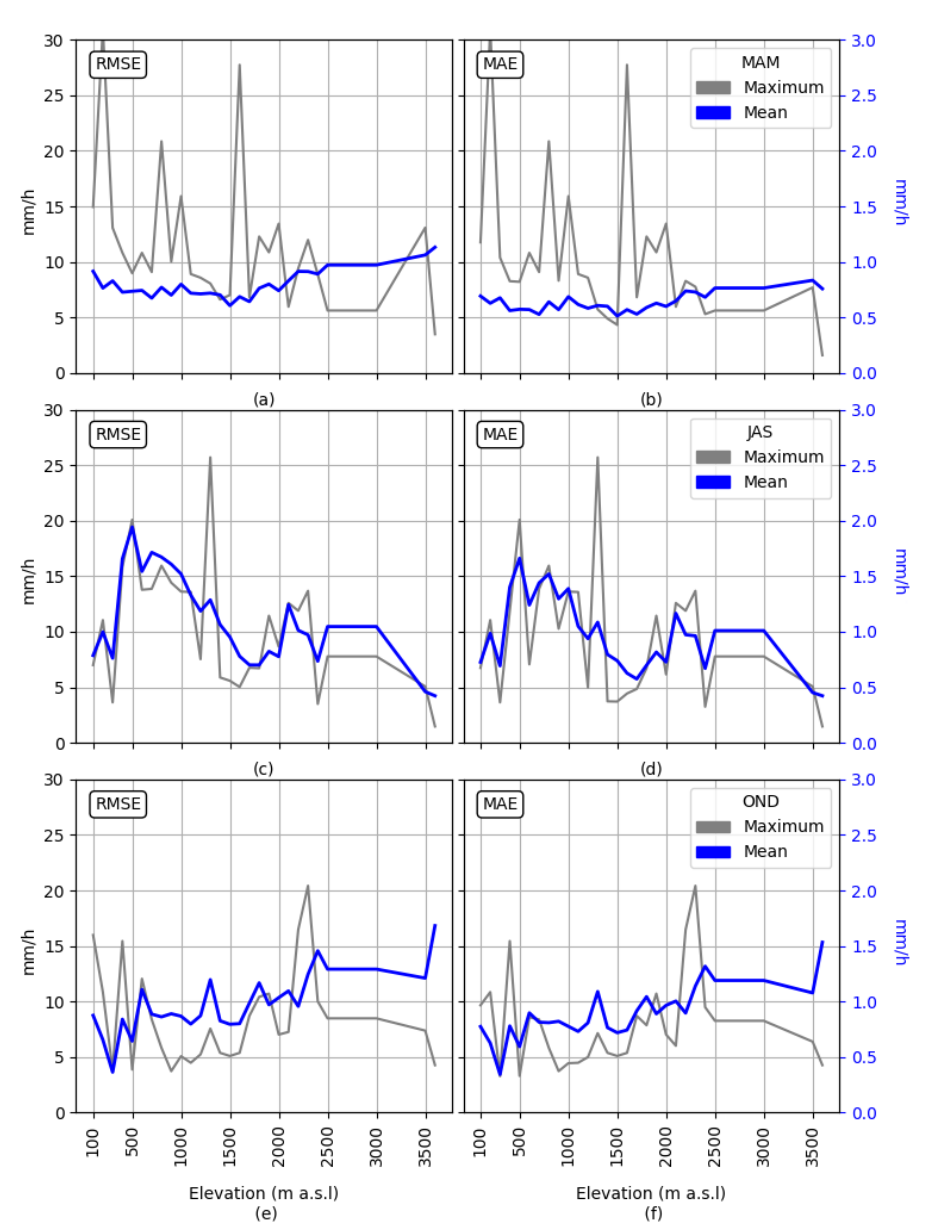
Figure 12. Maximum and mean RMSE and MAE values for different elevation levels for different time periods: MAM: March–April–May; JAS: July–August–September; OND: October–November–December. The ( a ) mean RMSE for MAM; ( b ) mean MAE for MAM; ( c ) mean RMSE for JAS; ( d ) mean MAE for JAS; ( e ) mean RMSE for OND; ( f ) mean MAE for